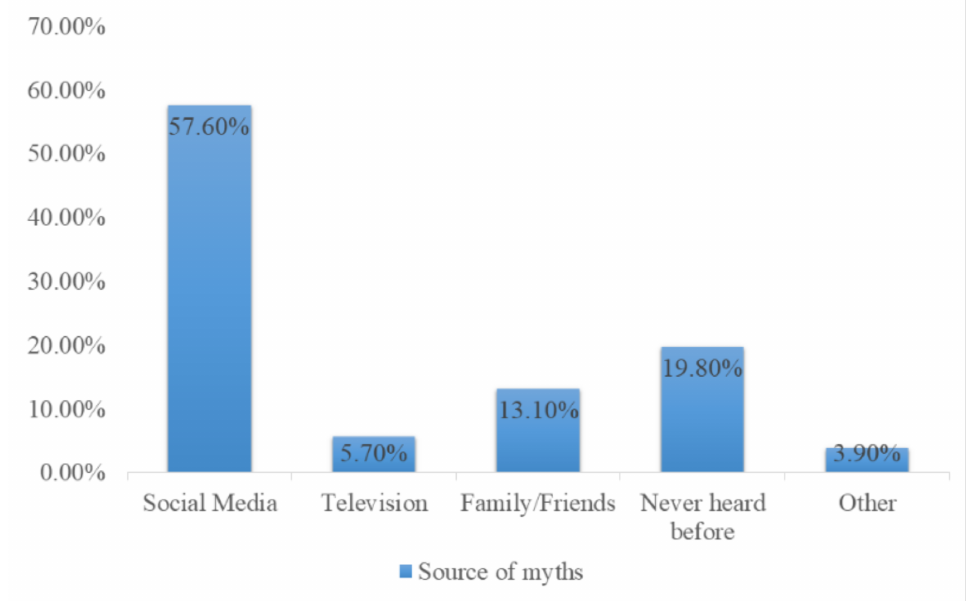
Figure 2. Sources of myths regarding the COVID-19 vaccine. Table 3. The acceptance, willingness to pay, and preference of participants regarding the COVID-19